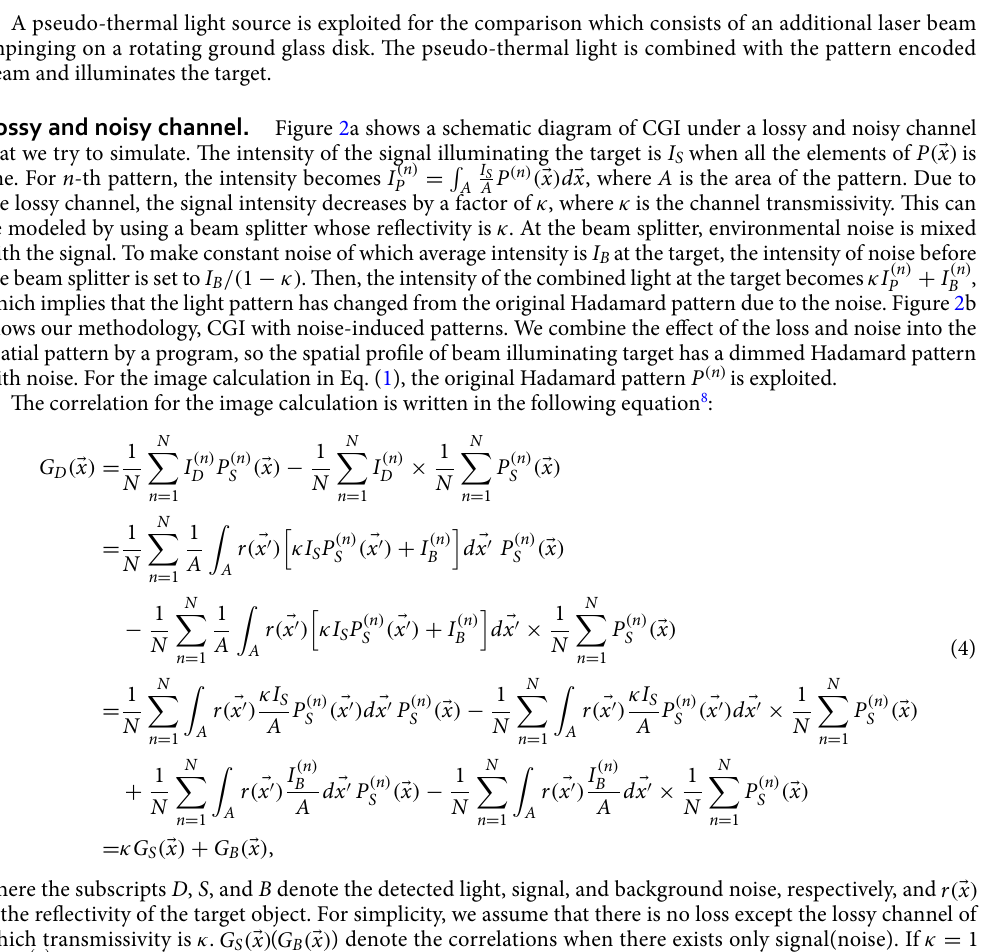
Figure 2. ( a ) A schematic diagram of CGI under a lossy and noisy channel. Starting from a light source with intensity I S , the intensity of the initially patterned light is I P = I B /( 1 − κ) . The two beams are mixed at a beam splitter whose reflectivity is κ , and the mixed beam illuminates the target. The reflected beam intensity is measured at the detector. ( b ) A schematic diagram of CGI with noise- induced patterns. The beam modulated by a noise-induced pattern ( P T ) illuminates the target, while the original pattern ( P S ) is used for the image calculation. P T is programmatically generated to have the same effects of noise and